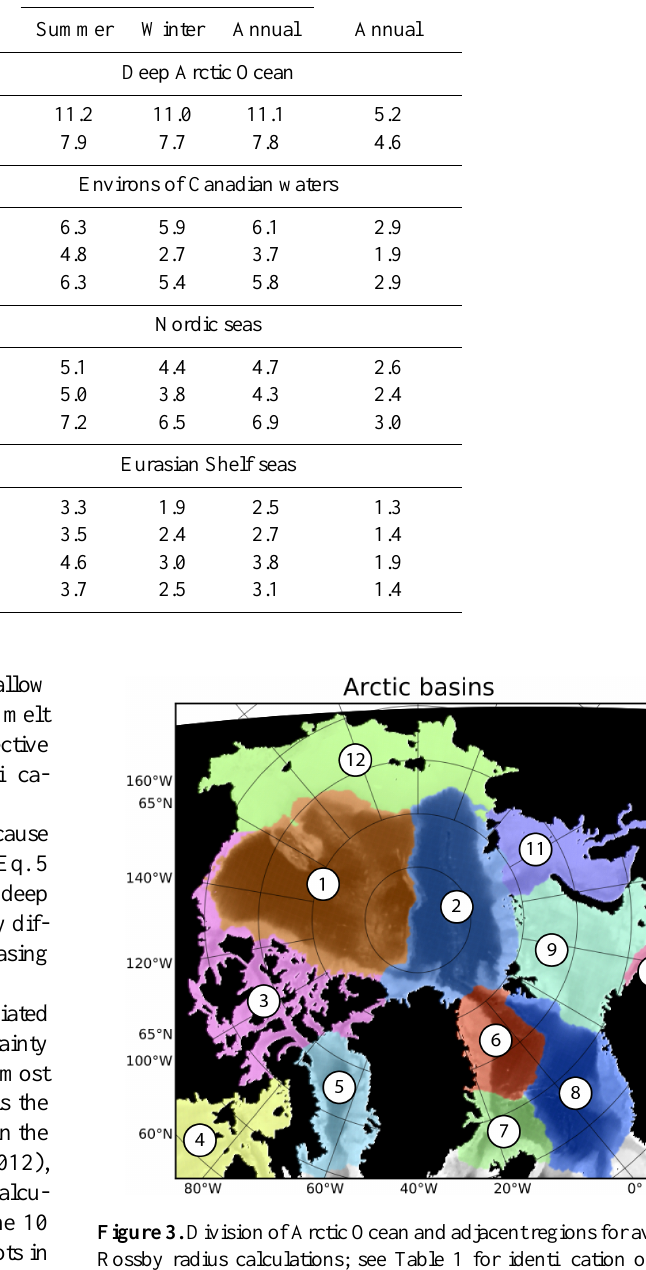
extent of September 2007 (Stroeve et al., 2008). PHC results lie generally within the lower, earlier range of BGEP values, but with evidence of smoothing, on which we comment be-